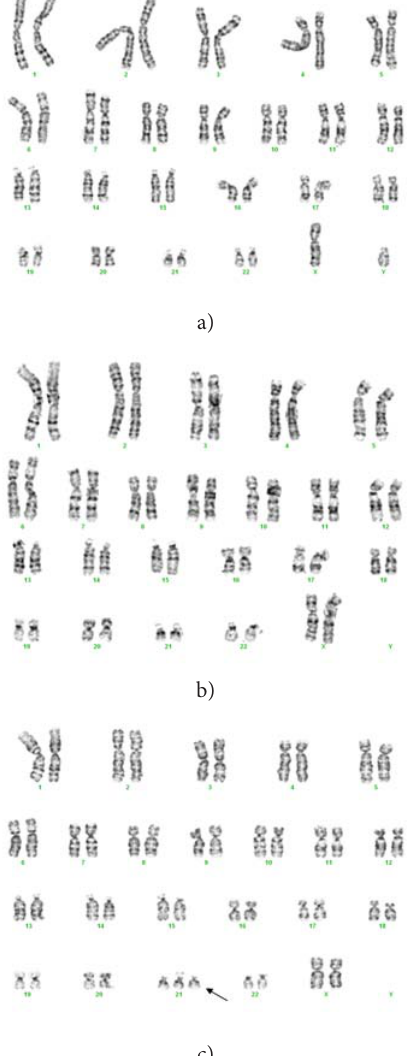
Fig. 1 . Normal male karyotype (There are two homologous chromosome 21 in cells) (a); normal female karyotype (There are two homologous chromosome 21 in cells) (b); abnormal female karyotype (In Down syndrome, there are three copies of chromosome 21)